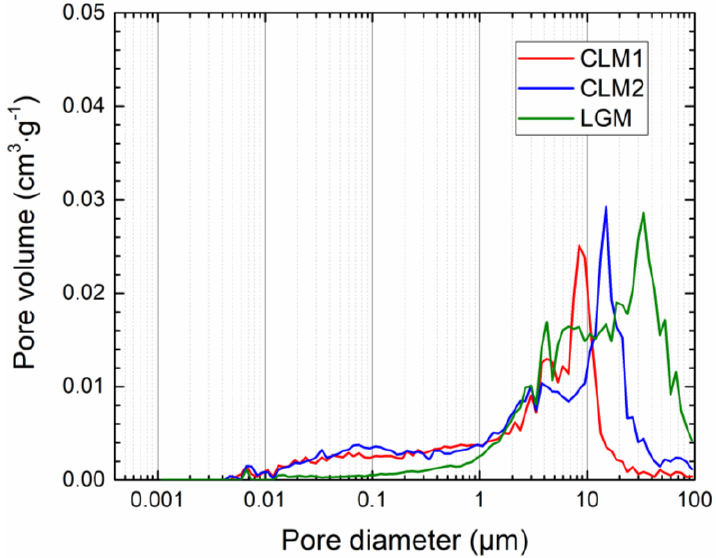
Figure 2. Incremental pore volume distribution of the researched plasters.